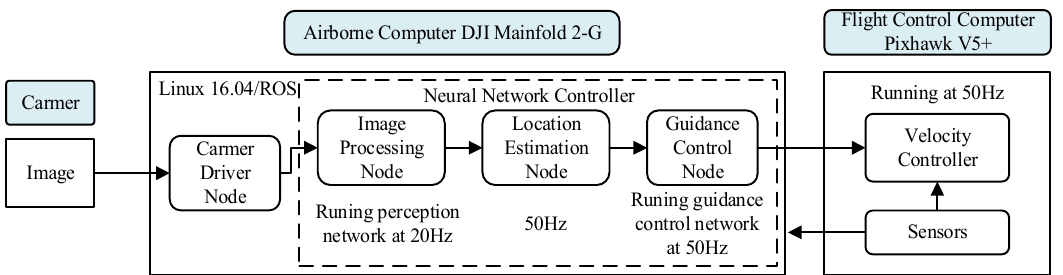
Figure 11. The structure and function of the UAV platform in the flight test.